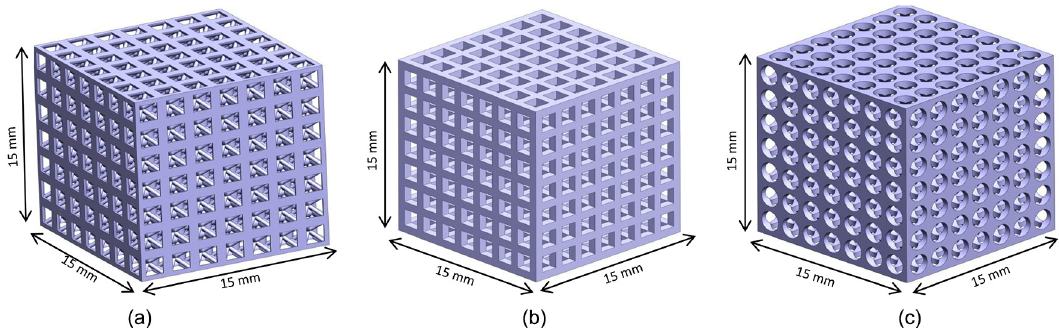
Fig. 2. 3D CAD models of the 82% porous structures; (a) BCC porous structure, (b) Cubic porous structure, (c) Spherical porous structure.